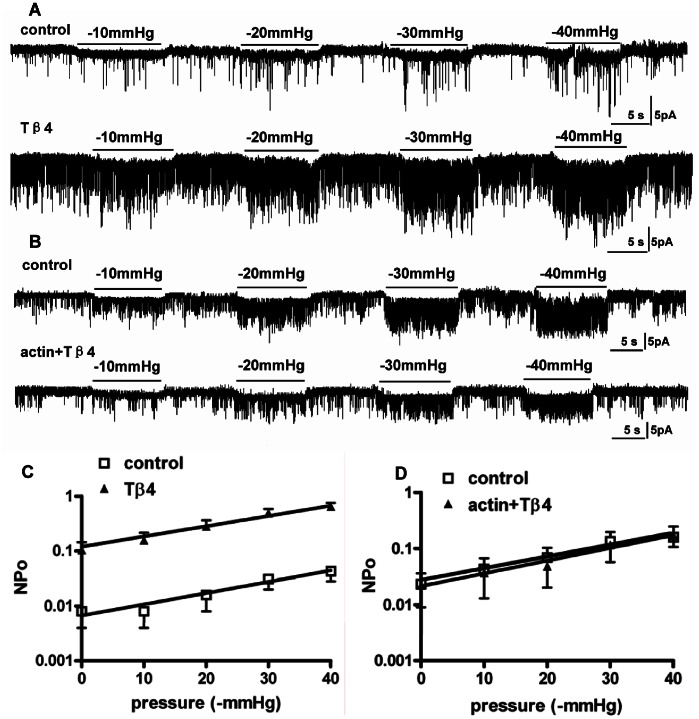
Effect of thymosin-β4.A: Recordings from the same patch before (control) and after thymosin-β4 (Tβ4, 50 µg/ml) treatment. B: Recordings from another patch before (control) and then treatment with G-actin (100 µg/ml) followed by thymosin-β4 (50 µg/ml) (actin+Tβ4). C: The semilog plot of NPo-pressure relationships before (control) and after treatment with thymosin-β4 (Tβ4). The two fits are parallel while the NPo is increased by thymosin-β4 (n = 7; P<0.05). D: The semilog plotting of NPo-pressure relationships before (control) and after treatment with G-actin followed by thymosin-β4 (actin+Tβ4). The two semilog plots are parallel and the intercept isn’t increased by thymosin-β4 due to combined application of G-actin (n = 5; P>0.05).